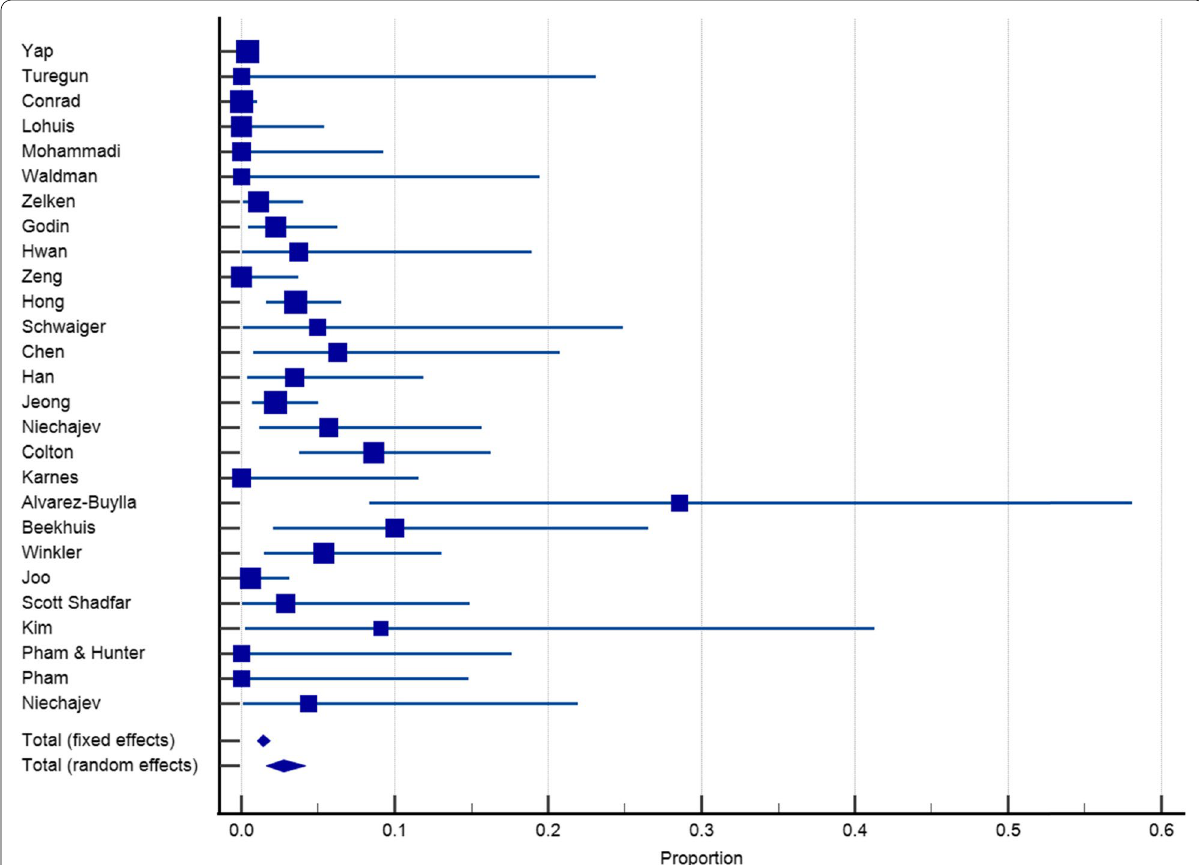
Fig. 2 The weighted mean percentage of Infection rates reported synthetic materials in both fixed and